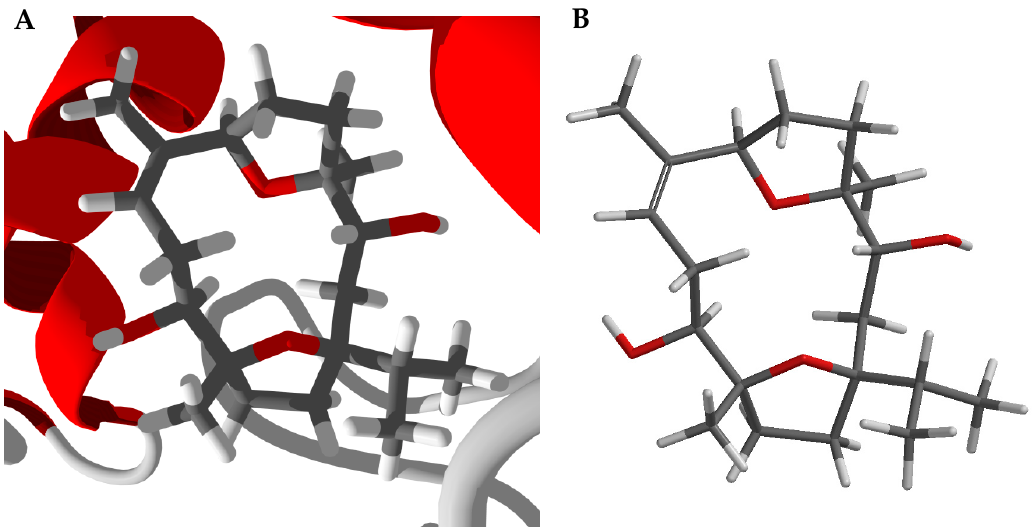
Figure 5. Boscartin A. ( A ): Lowest-energy docked pose of boscartin A with Torpedo californica acetylcholinesterase (PDB 2cek). ( B ): Calculated lowest-energy conformation of boscartin A at the M06-2X/6-31G*/SM8 level of theory [31].